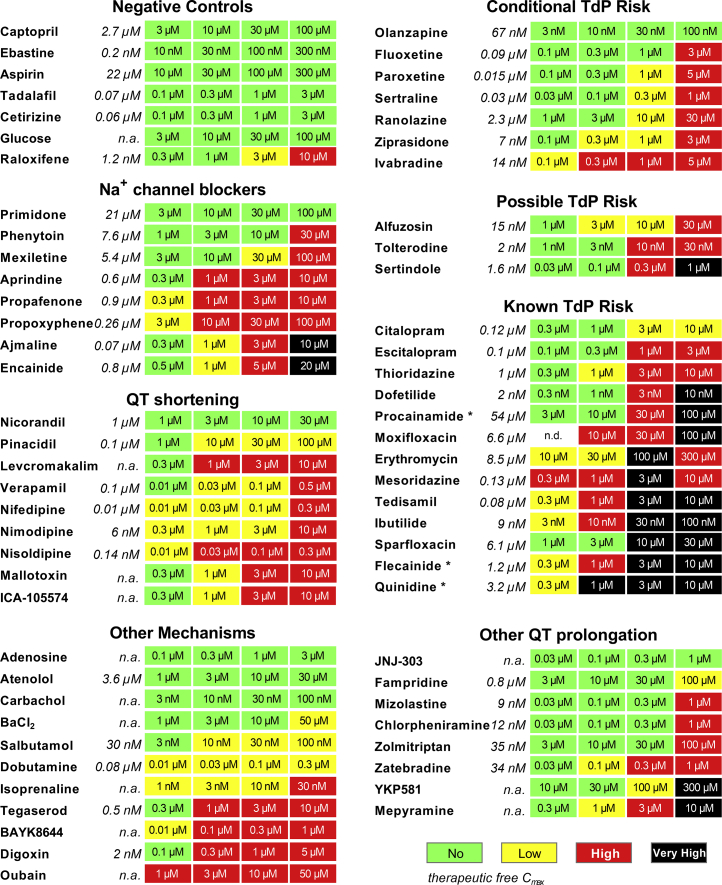
Cardiac Hazard Scoring of Reference DrugsConditional TdP, Possible TdP, and Known TdP groups represent drugs that are listed on CredibleMeds. Concentrations were selected based on the therapeutic free Cmax (shown in italic). ∗Drugs that can also be categorized as Na+ channel blockers. n.d., not determined; n.a., not available.